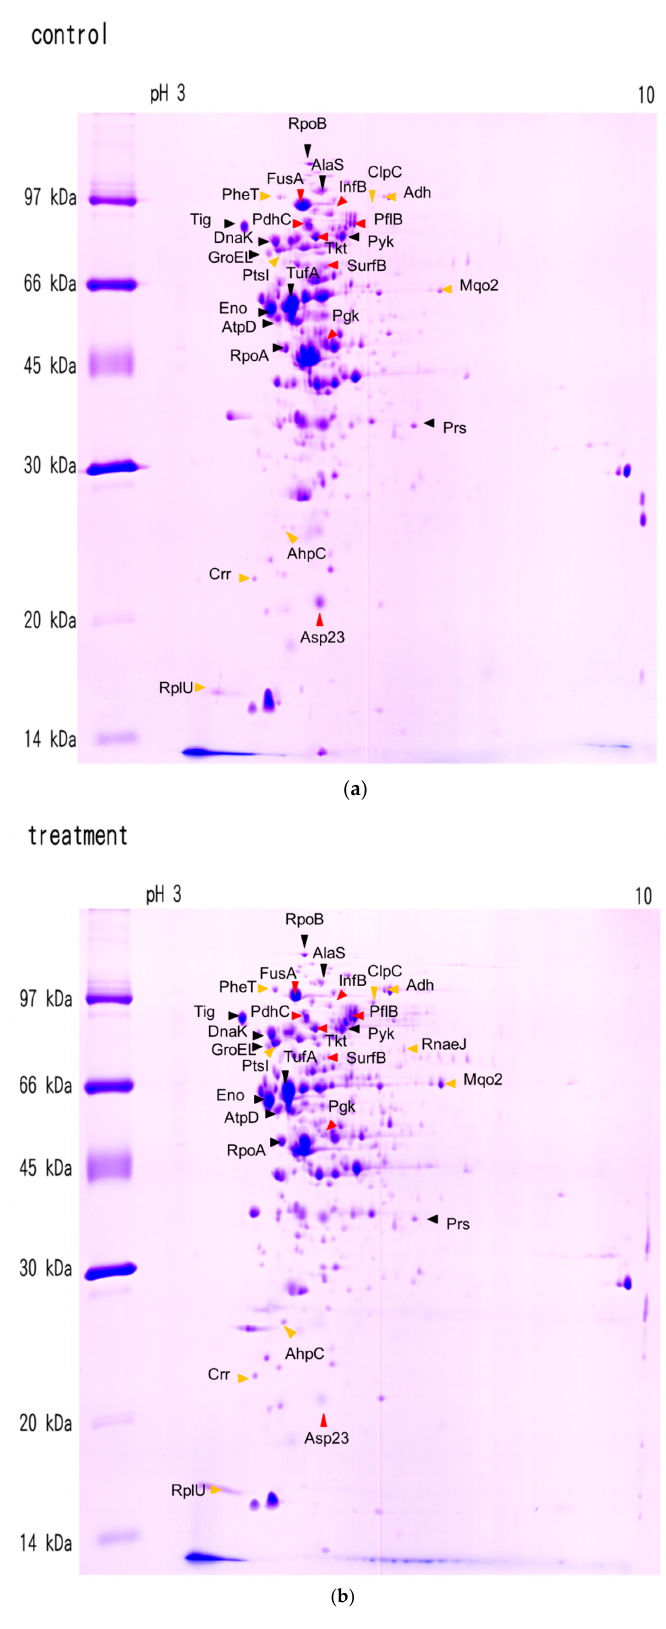
Figure 2. The 2D gel showing spots of interest with proteins isolated from untreated MRSA ( a ) and proteins from ursolic acid–treated MRSA ( b ); 2D-PAGE was used to separate cytoplasmic proteins in the p I range of three to 10 according to their p Is and molecular weight. Proteins induced by the ursolic acid appear yellow, repressed proteins appear red, and proteins with no significantly changes are indicated as black. Table 3. Changes in protein expression in MRSA following treatment with ursolic acid.